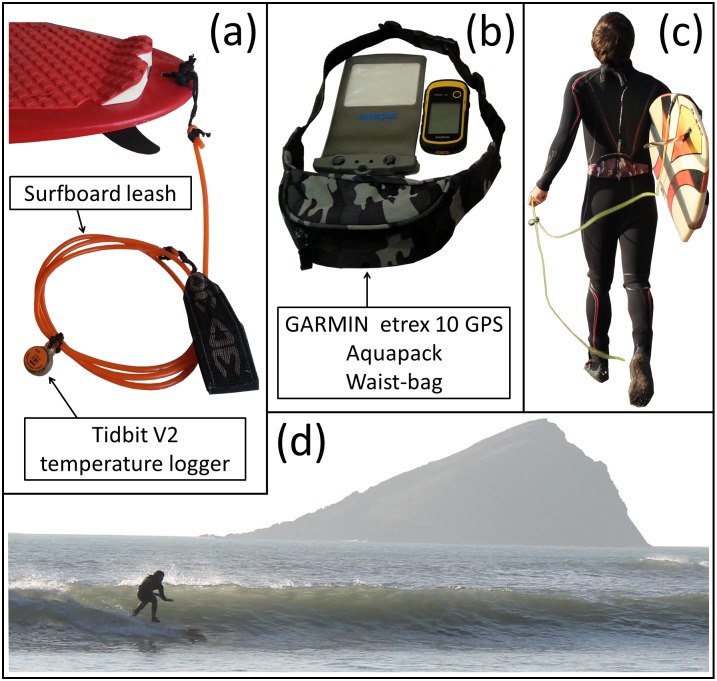
Equipment used in the study and surfer set-up.(a) Shows the Tidbit V2 temperature logger attached at mid-point to the surfboard leash. HOBOware software and HOBO USB Optic Base Station (BASE-U-4) were used by the surfer to launch the Tidbit V2 temperature logger prior to each session, and then to upload data post session. (b) Shows the GARMIN extrex 10 GPS, water-resistant Aquapac and waist-bag worn by the surfer. Information at one second intervals on location (latitude and longitude), time, distance, speed and orientation for each surf, were extracted from the GPS device post session. (c) Shows the surfer equipped with the sensors, and (d) shows the surfer collecting data during a session at Wembury beach. Consent to publication was obtained from the participant in this figure.